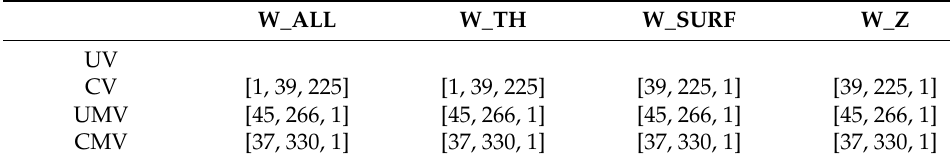
Figure 11. Histogram of ( a ) the most common sets of parameters for the best 5% of the CMV results and the W_ALL weight set and of ( b ) the best 5% of the CMV results and the TH weight set (the darker the colour, the higher the frequency of occurrences). Table 8. Dominant sets of parameters in the optimisation processes performed. Table 8. Dominant sets of parameters in the optimisation processes performed.